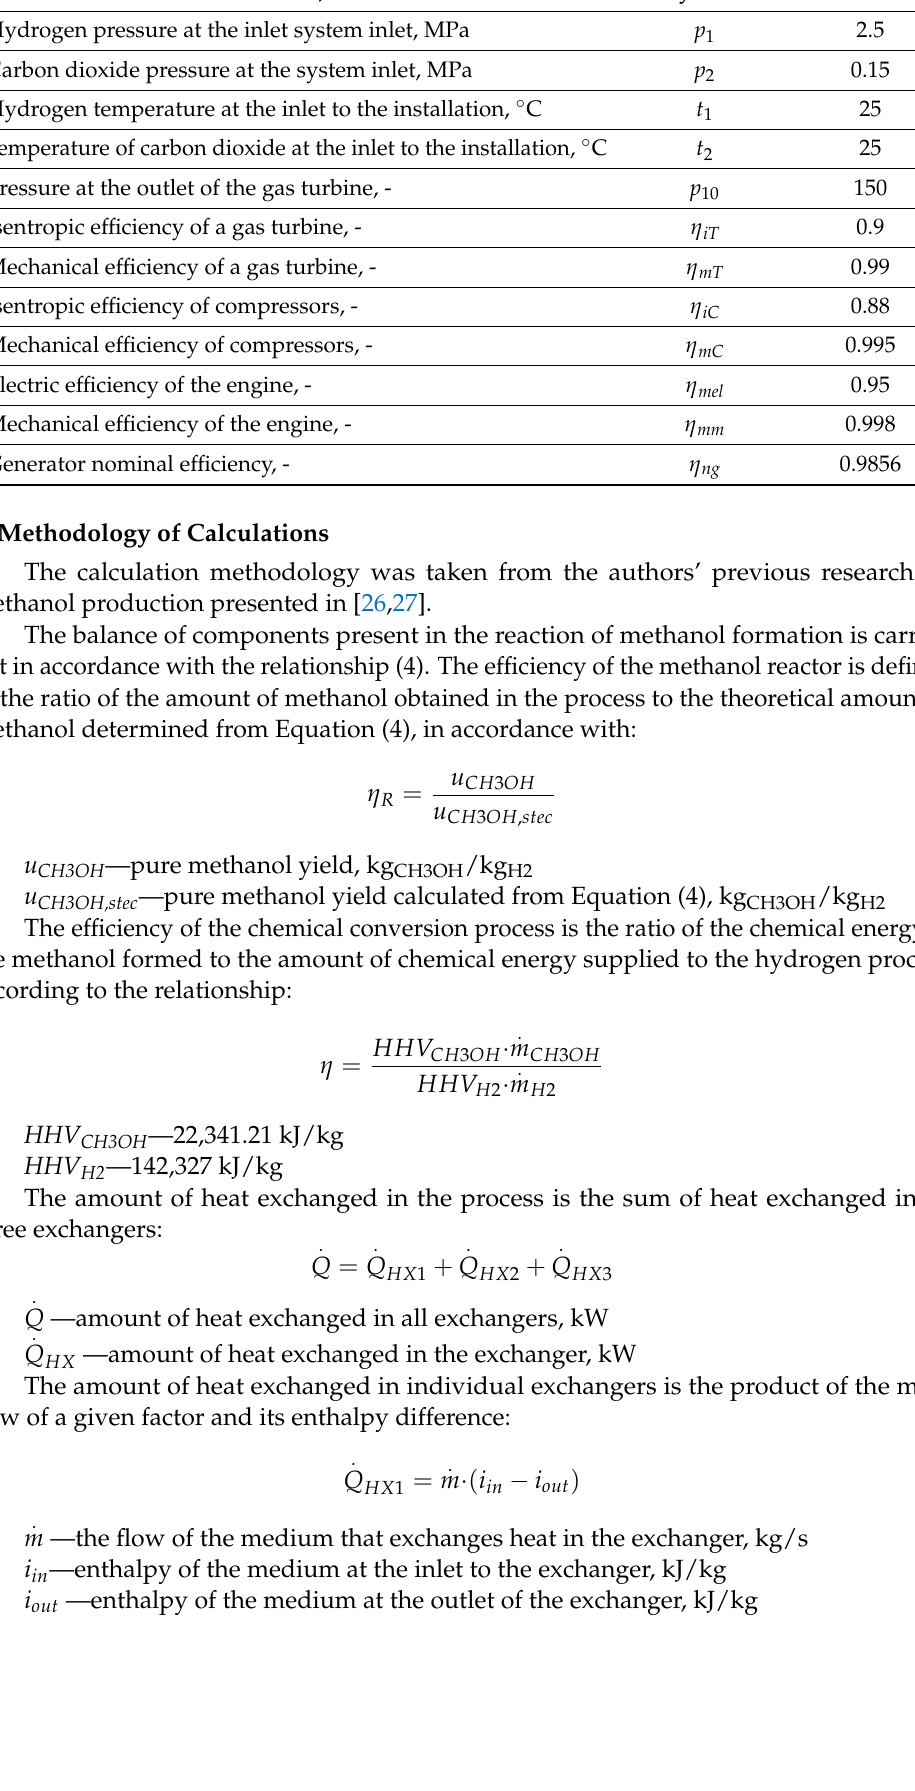
Table 1. Assumptions for the installation of methanol production in the gas turbine cycle. Parameter, Unit Symbol Value p 1